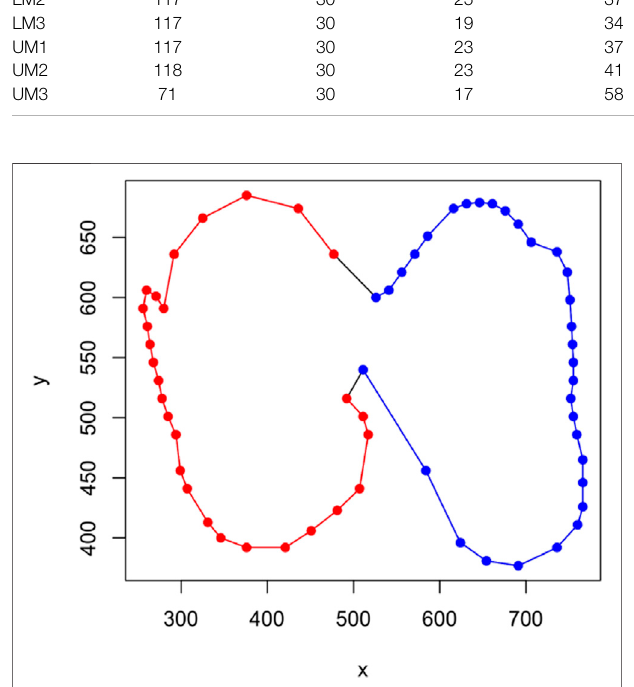
FIGURE 4 | An example of how a partially observed tooth is obtained from a fully observed one in the simulated setting . The fi gure shows a lower molar 1 (LM1) from the tribe Alcelaphini with red points representing the extractedpiecefrom theLeft(1)sideand bluepoints dothesame forthe Right (2)